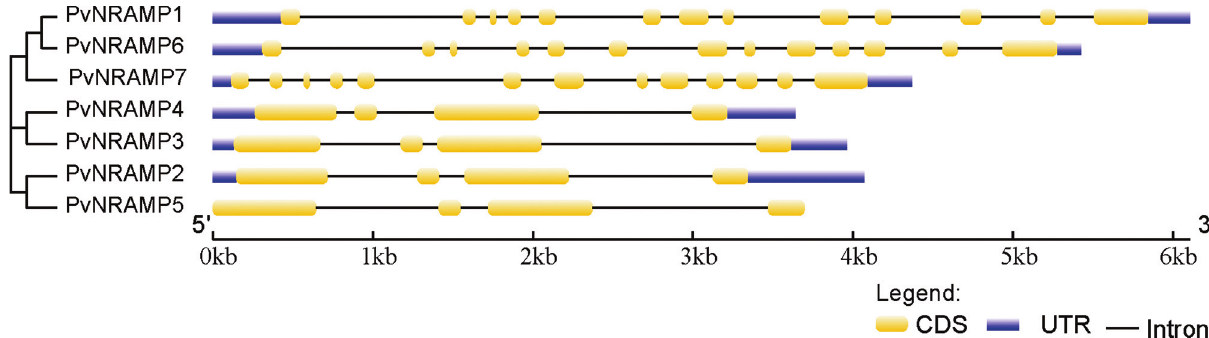
Figure 3 - Schematic structure of PvNRAMP in P. vulgaris . Phylogenetic tree with introns, exons and UTRs. Lines connected to similar exons and differ- entcolorsindicatenovelexons.ThephylogenetictreewasgeneratedbasedontheMaximumLikelihoodstatisticalmethodandthephylogenetictreemust show the numbers at the internal